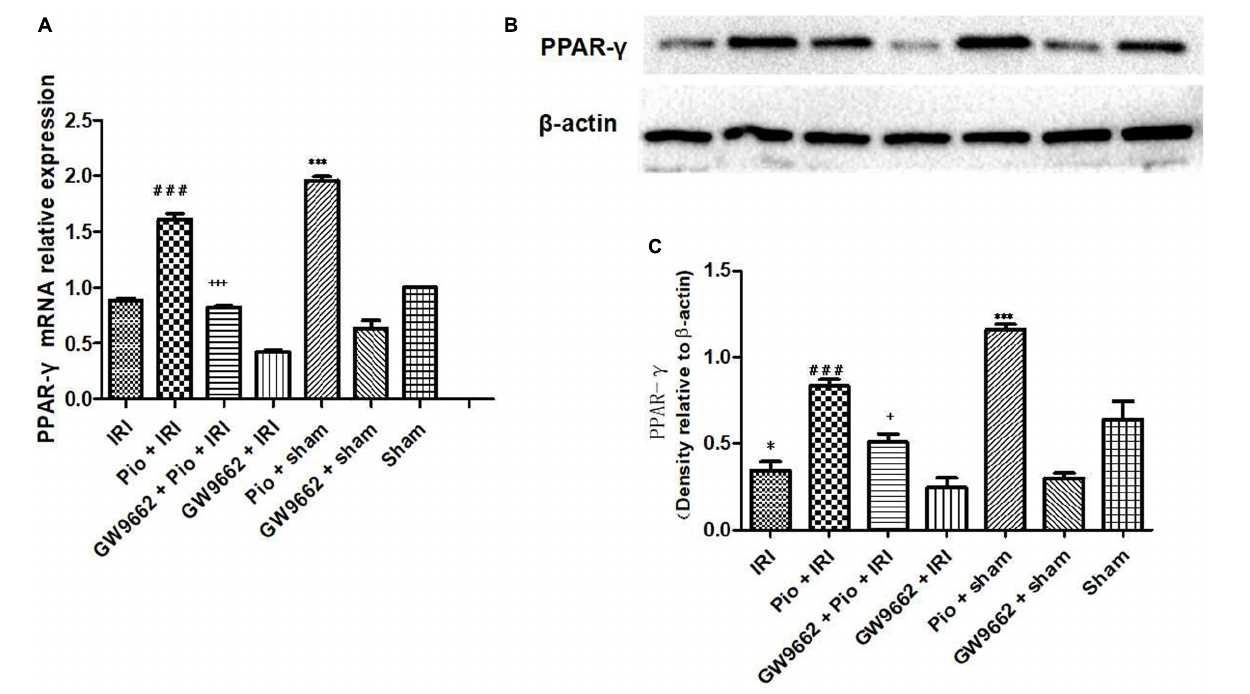
FIGURE 4 | Pioglitazone up-regulates PPAR- γ mRNA and protein expression. (A) Quantitative analysis of PPAR- γ mRNA in the kidneys at 24 h post renal IRI. (B) Representative western blots indicating PPAR- γ protein level in the kidneys at 24 h after renal IRI. (C) Quantitative analysis of PPAR- γ protein level in the kidneys. Values are expressed as mean ± SE ( n = 3). Compared to the sham group, ∗ represents p < 0.05, and ∗∗∗ represents p < 0.001; compared to the IRI group, ### represents p < 0.001; compared to the Pio + IRI group, + represents p < 0.05, and +++ represents p < 0.001.